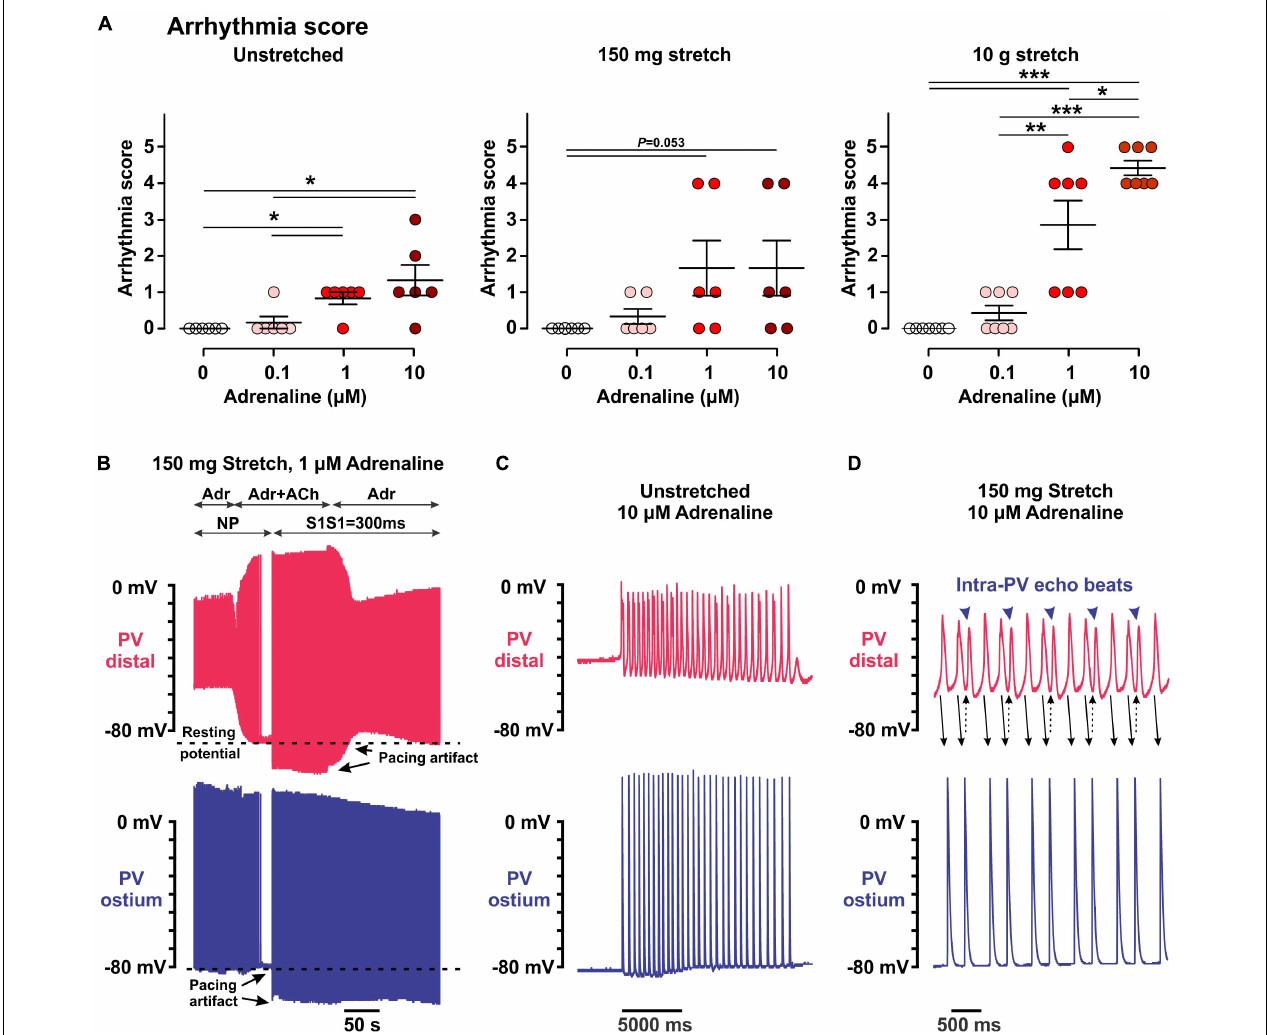
FIGURE 3 | Arrhythmic events induced within the pulmonary vein (PV) myocardium by low (25–100 nmol/L) and high (1–10 µ mol/L) concentrations of adrenaline in unstretched and stretched (150 mg and 10.5 g) preparations. (A) Arrhythmia score calculated as described in the section “Materials and Methods.” N = 6–7 rats. P values are calculated by repeated measurements two-way ANOVA with Bonferroni correction. (B – D) Representative examples of arrhythmic events recorded in PV preparations under different conditions. Two simultaneous microelectrode recordings from PV dis (top recording in red) and PV ost (bottom recording in blue) are shown for each event. (B) A brief application of 1 µ mol/L acetylcholine (ACh) in 150 mg stretched preparation hyperpolarized the RP in PV dis back to a baseline level and suppressed spontaneous PV activity (no pacing, NP) under 1 µ mol/L adrenaline (Adr) application. After ACh washout, spontaneous slow PV rhythm (arrhythmia score is 3) was suppressed by atrial pacing (S1S1 = 300 ms). (C,D) Stable slow rhythm (arrhythmia score is 4, C ) and fast regular rhythm (arrhythmia score is 5, D ) induced by 10 µ mol/L adrenaline in unstretched (C) and 150 mg stretched (D) PV preparations.